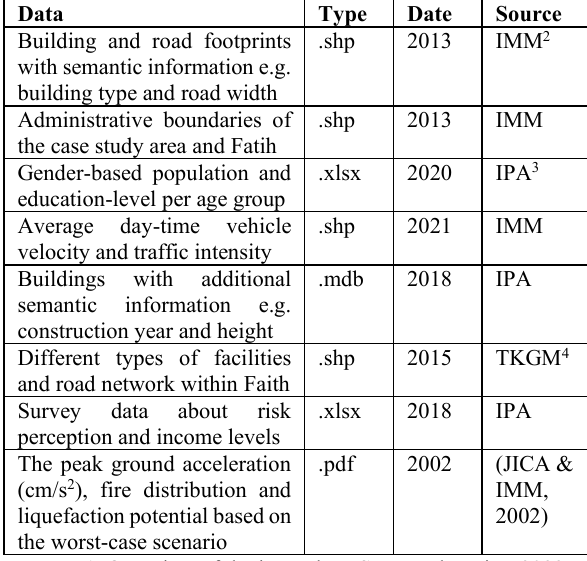
Table 1. Overview of the input data. Source: de Vries,